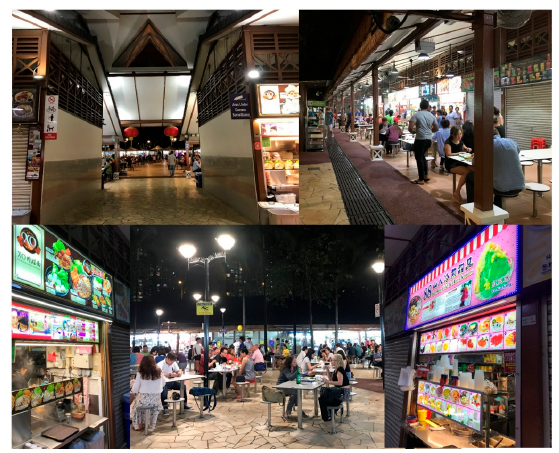
Figure 7. A cluster of street stands in Singapore.